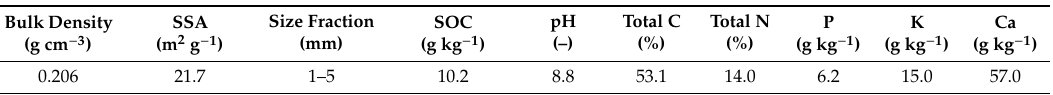
Table 2. Physical and chemical properties of biochar provided by Austrian company Sonnenerde [46,48].